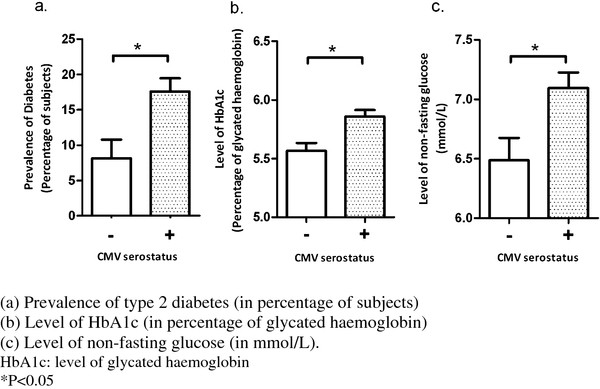
Comparison of glucose regulation in relation to CMV serostatus. ( a) Prevalence of type 2 diabetes (in percentage of subjects), ( b) Level of HbA1c (in percentage of glycated haemoglobin). ( c) Level of non-fasting glucose (in mmol/L). HbA1c: level of glycated haemoglobin *P < 0.05.